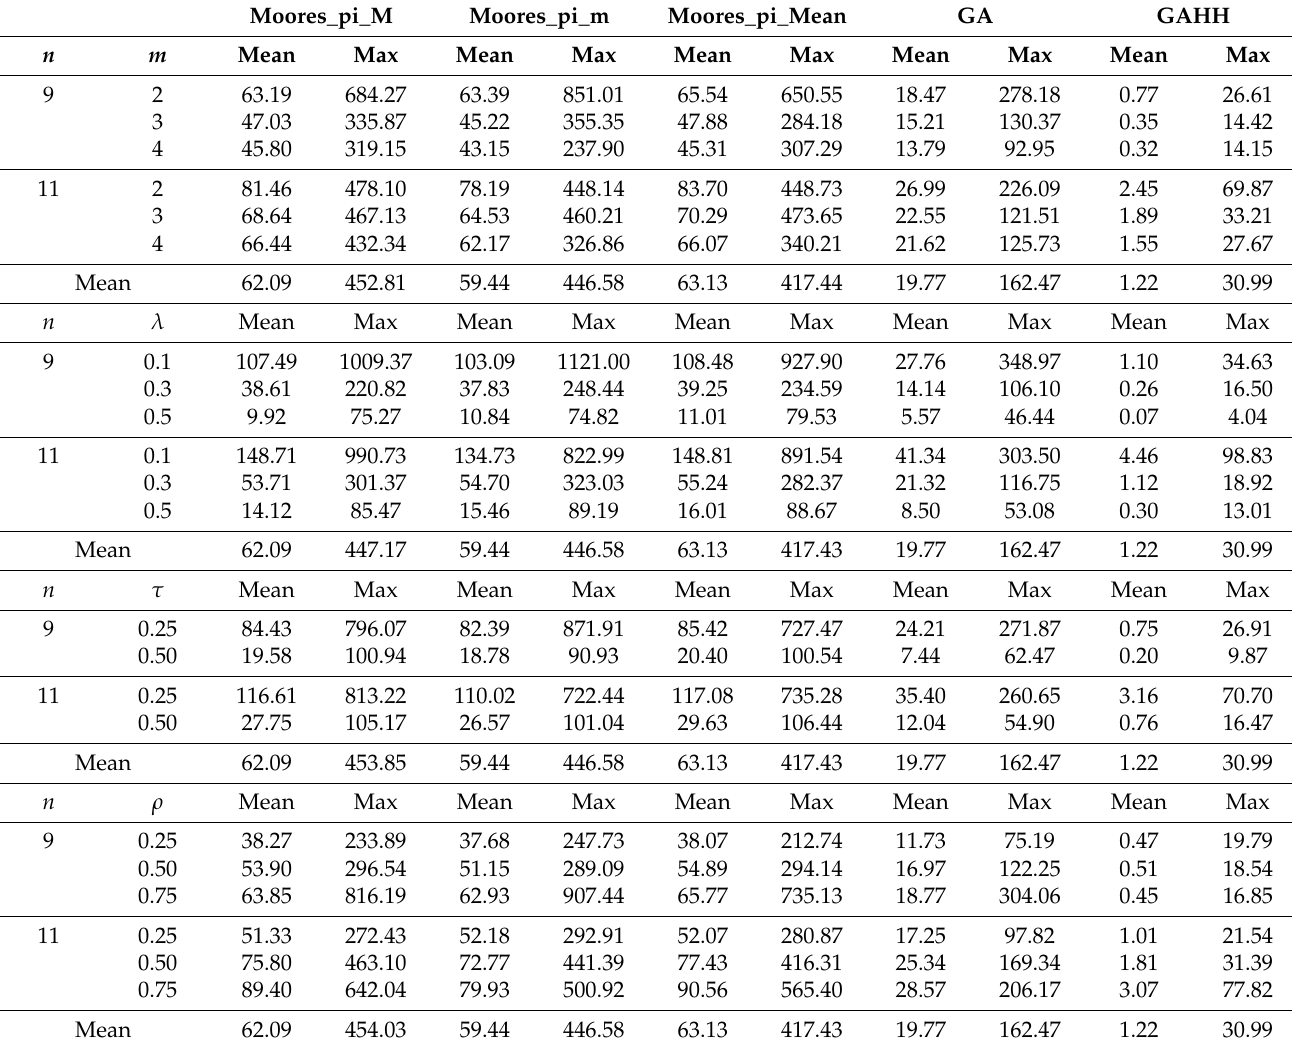
Table 2. AEPs of the proposed heuristics and algorithms for small n